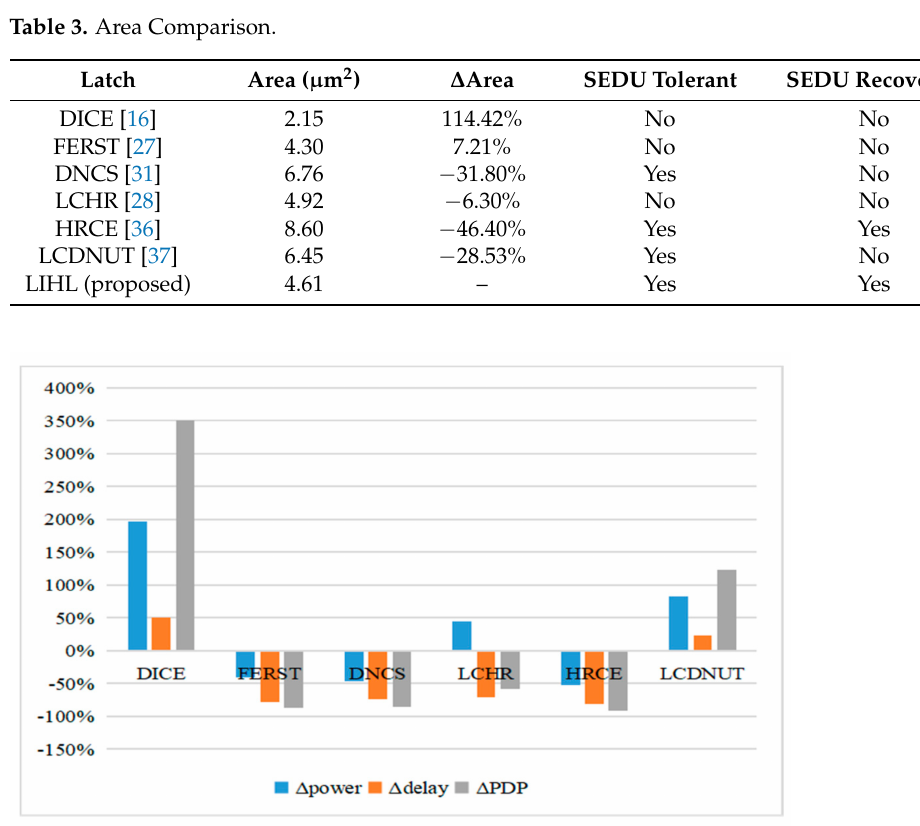
Figure 22. ∆ power, ∆ delay, and ∆ PDP of various latch designs compare to the